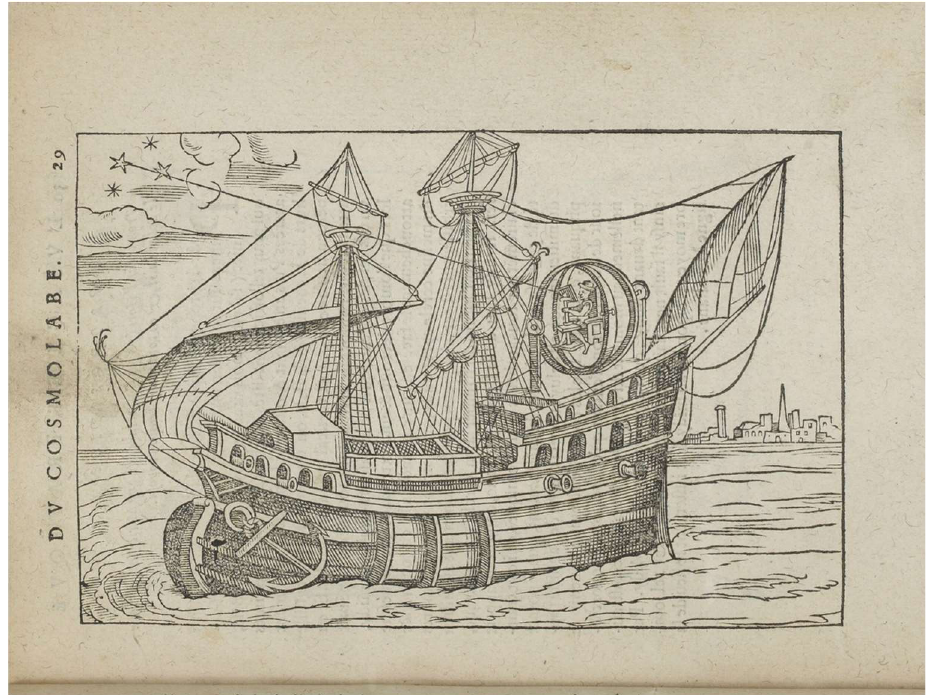
Figure 5. Man seated in a gimballed chair aboard a ship, a drawing from Jacques Besson’s Le Cosmolabe , 1567, p. 29. Source: Gallica Ebooks.